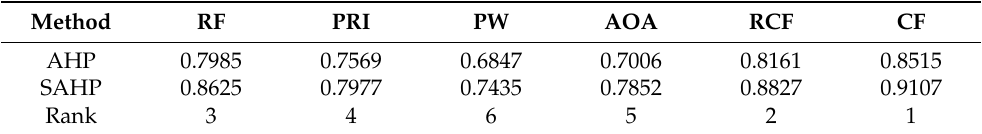
Table 5. Evaluation results based on AHP and SAHP.